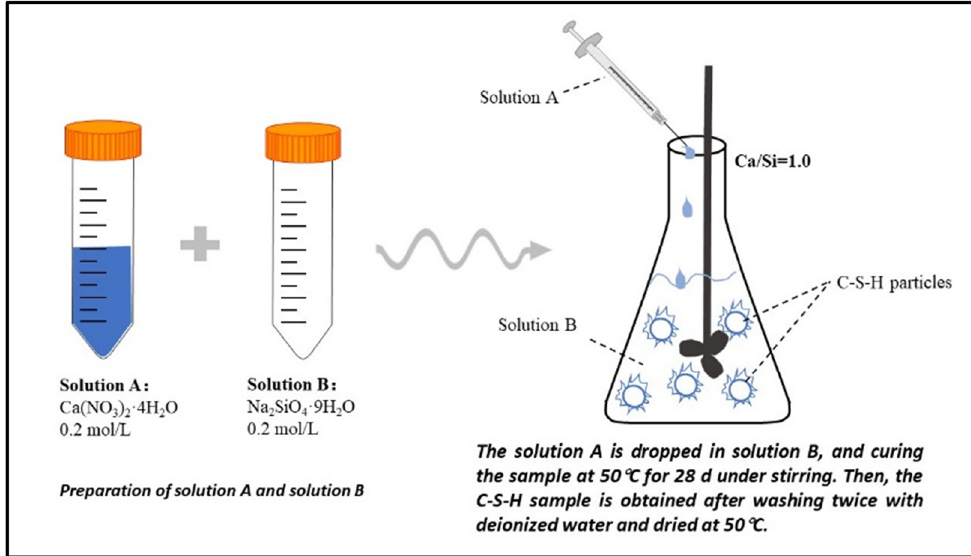
Figure 1: Schematic diagram of the preparation process of C – S – H